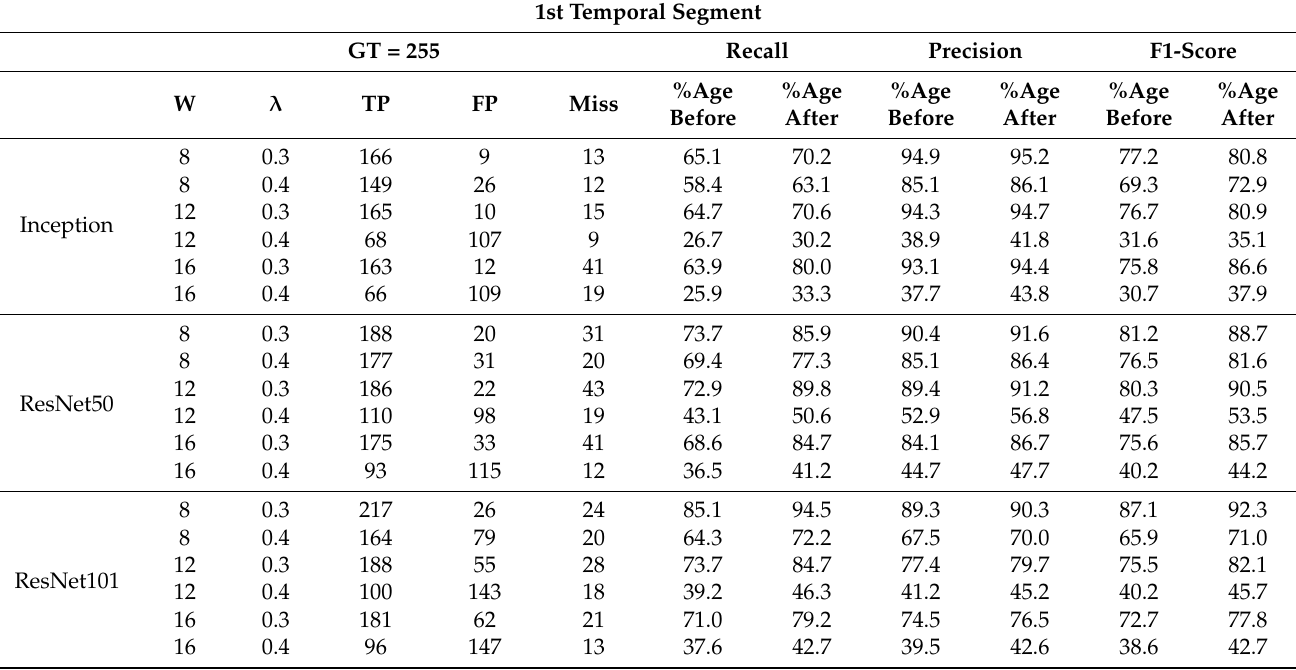
Table A2. Detections and refinement results of 1st temporal